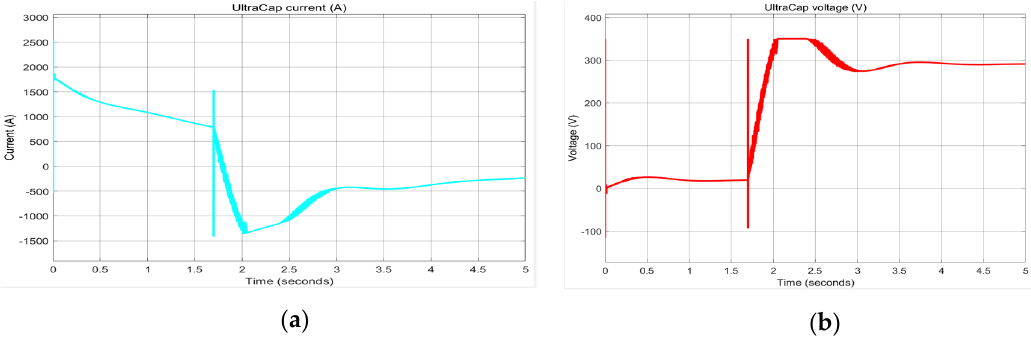
Figure 34. Supercapacitor (SC) supplying the PMDCM during sharp changes in the load torque; ( a ) SC current; ( b ) SC voltage.